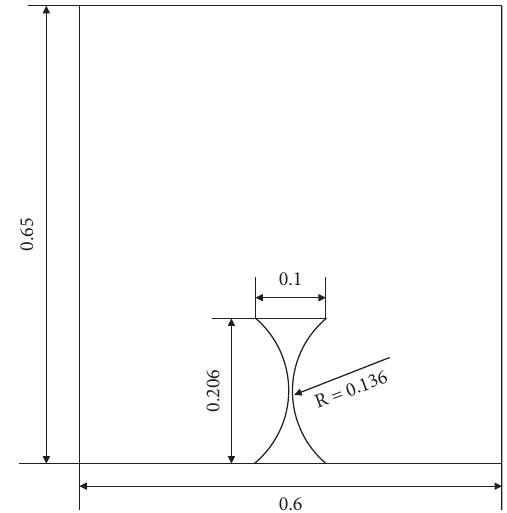
Figure 8: Dimensions of the double-side curved baffle (unit: